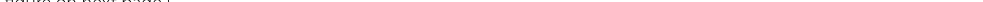
figure on next Fig. 6 Expression of circ_0080145, circ 0051886, miR‑203, miR‑637 and ABL1 mRNA/protein and BCR/ABL1 between the K562 group, K562 p‑circ_0080145 group, K562 circ_0051886 group and K562 p‑circ_0080145 p‑circ_0051886 group (*P value < 0.05 vs. K562 group). A + + + + The expression of circ_0080145 was increased by the presence of p‑circ_0080145 in K562 cells; B The expression of circ_0051886 was increased by the presence of p‑circ_0051886 in K562 cells; C The expression of miR‑203 was decreased by the presence of p‑circ_0080145 in K562 cells; D The expression of miR‑637 was decreased by the presence of p‑circ_0051886 in K562 cells; E The expression of ABL1 mRNA was increased by the presence of p‑circ_0080145 and/or p‑circ_0051886 in K562 cells; F The expression of ABL1 protein was increased by the presence of p‑circ_0080145 and/or p‑circ_0051886 in K562 cells; G The proliferation of K562 cells was promoted by the presence of p‑circ_0080145 and/or p‑circ 0051886; H The apoptosis rate of K562 cells was suppressed by the presence of p‑circ_0080145 and/or p‑circ 0051886; I The expression of BCR/ABL1 mRNA was not influenced by the presence of p‑circ_0080145 and/or p‑circ_0051886 in K562